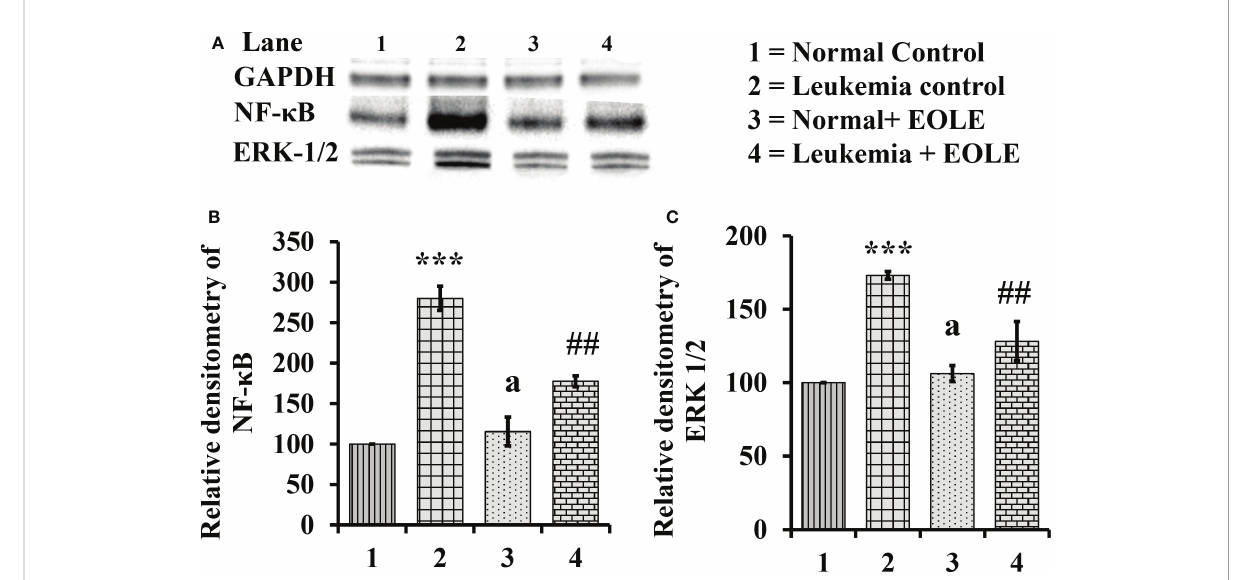
FIGURE 8 Figure showing the expression of NF- k B and ERK1/2 in the bone marrow of mice, where (A) Image of NF- k B and ERK1/2 protein bands, (B) Densitometry plot for NF- k B, (C) Densitometry plot for ERK1/2; values are expressed as mean ± SD of 3 observations. The statistical signi fi cance was tested using one-way ANOVA following Tukey ’ s multiple comparison tests by comparing the values as, Group-1 vs . Group-2, 3; Group-2 vs . Group- 4. P-value, p < 0.05 was considered as statistically signi fi cant. When compared with Group-1 the level of signi fi cance was denoted as, a = not signi fi cant when p > 0.05; * when p < 0.05; ** when p < 0.01; and ***when p < 0.001. When compared with Group-2, b = not signi fi cant when p > 0.05; # when p < 0.05; ## when p < 0.01; ### when p <